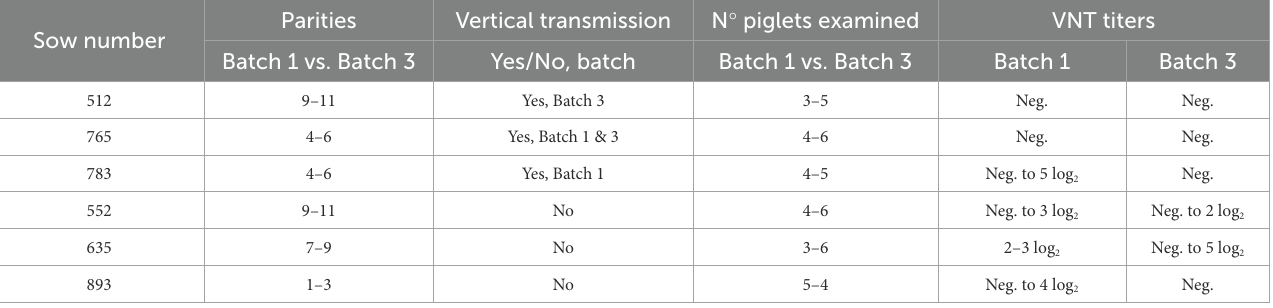
TABLE 4 Parity, PRRSV-1 vertical transmission, and neutralizing antibodies titers of the offspring (2 weeks of age) of six sows that were present in both Batch 1 and Batch 3.